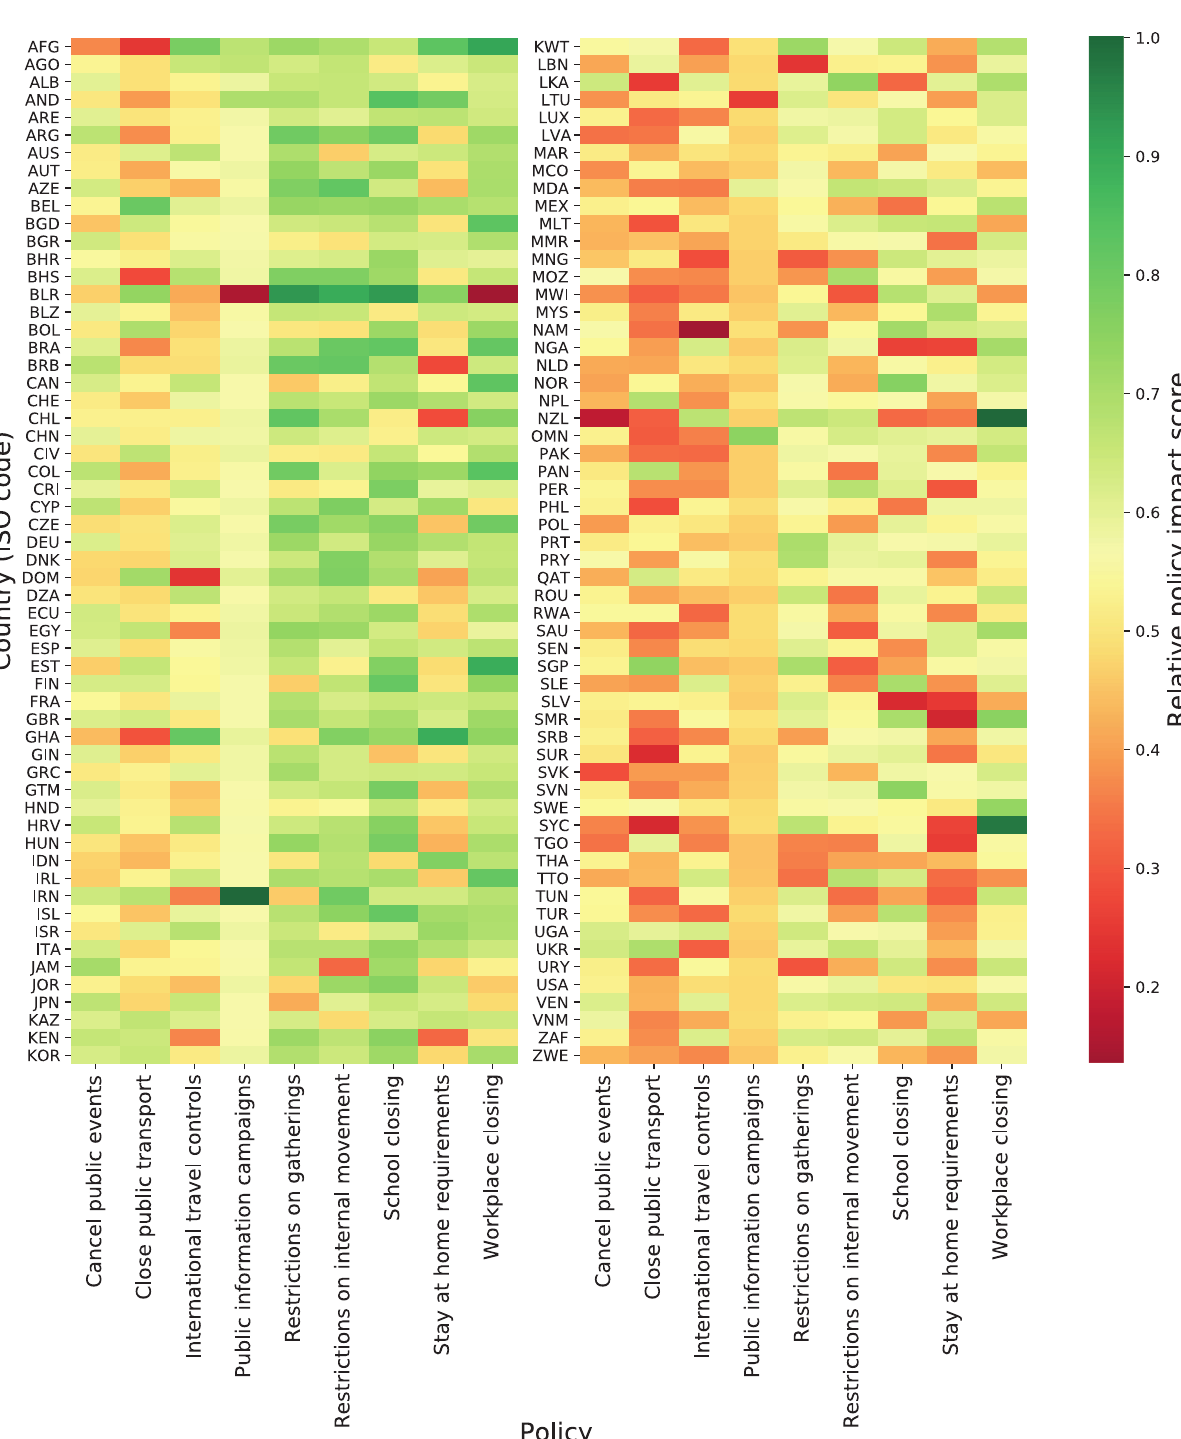
Fig 4. Policy impact score—116 countries. Relative policy impact score for 116 countries and nine policies. It represents how much a policy affects the R E on each country on average. The more red the color, the lower the